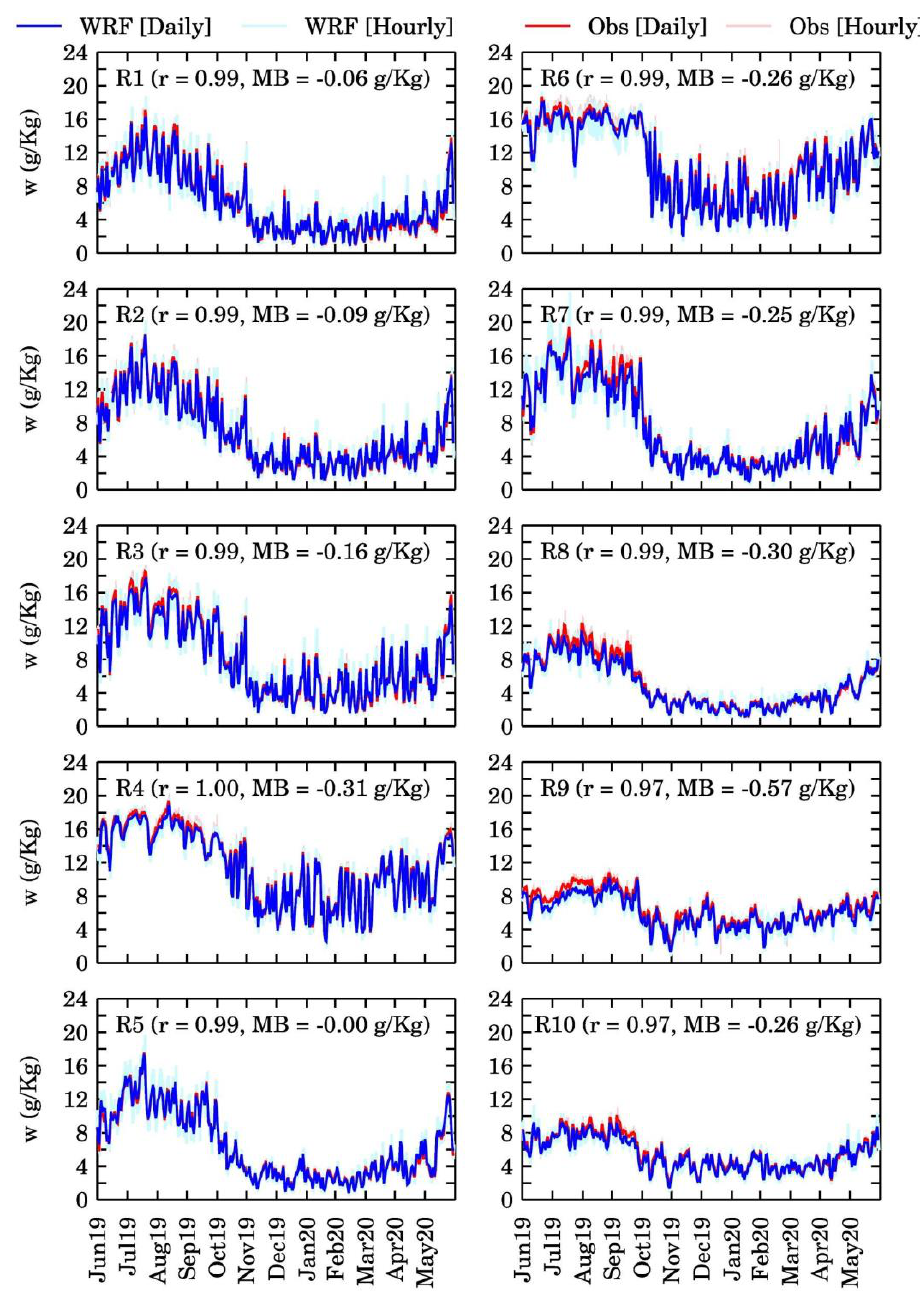
Figure 7. Seasonal variations in hourly and daily observed and first-day model simulated water vapor mixing ratio (w) in 10 EPA regions during June 2019 to May 2020. Pearson correlation coefficient (r) and mean bias (MB) for each region estimated using paired data for the full year are also shown.